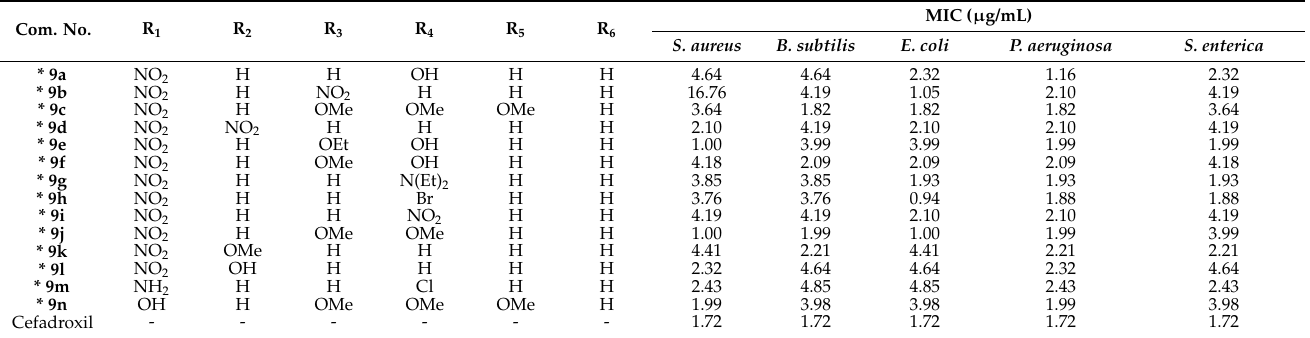
Table 15. Antibacterial activity of the substituted chalcones contaning nitor, amino, hydroxyl, methoxy, and chloro groups ( 9a – n ).